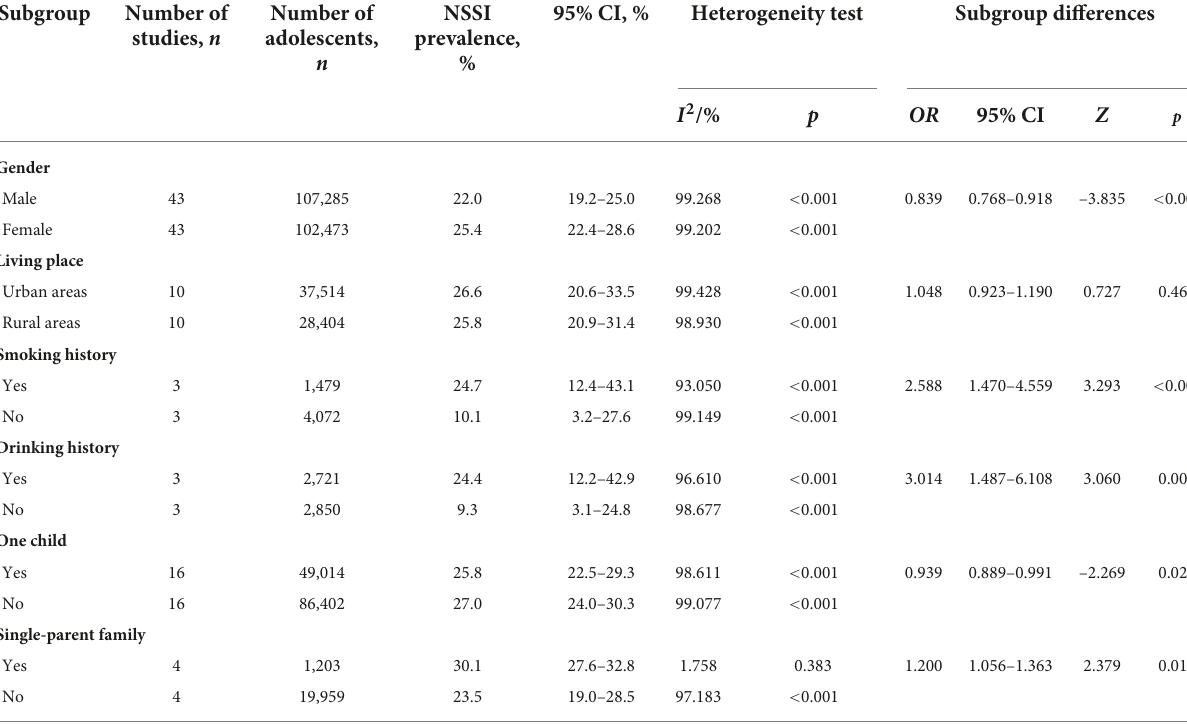
TABLE 4 Prevalence of non-suicidal self-injury among adolescents based on subgroup